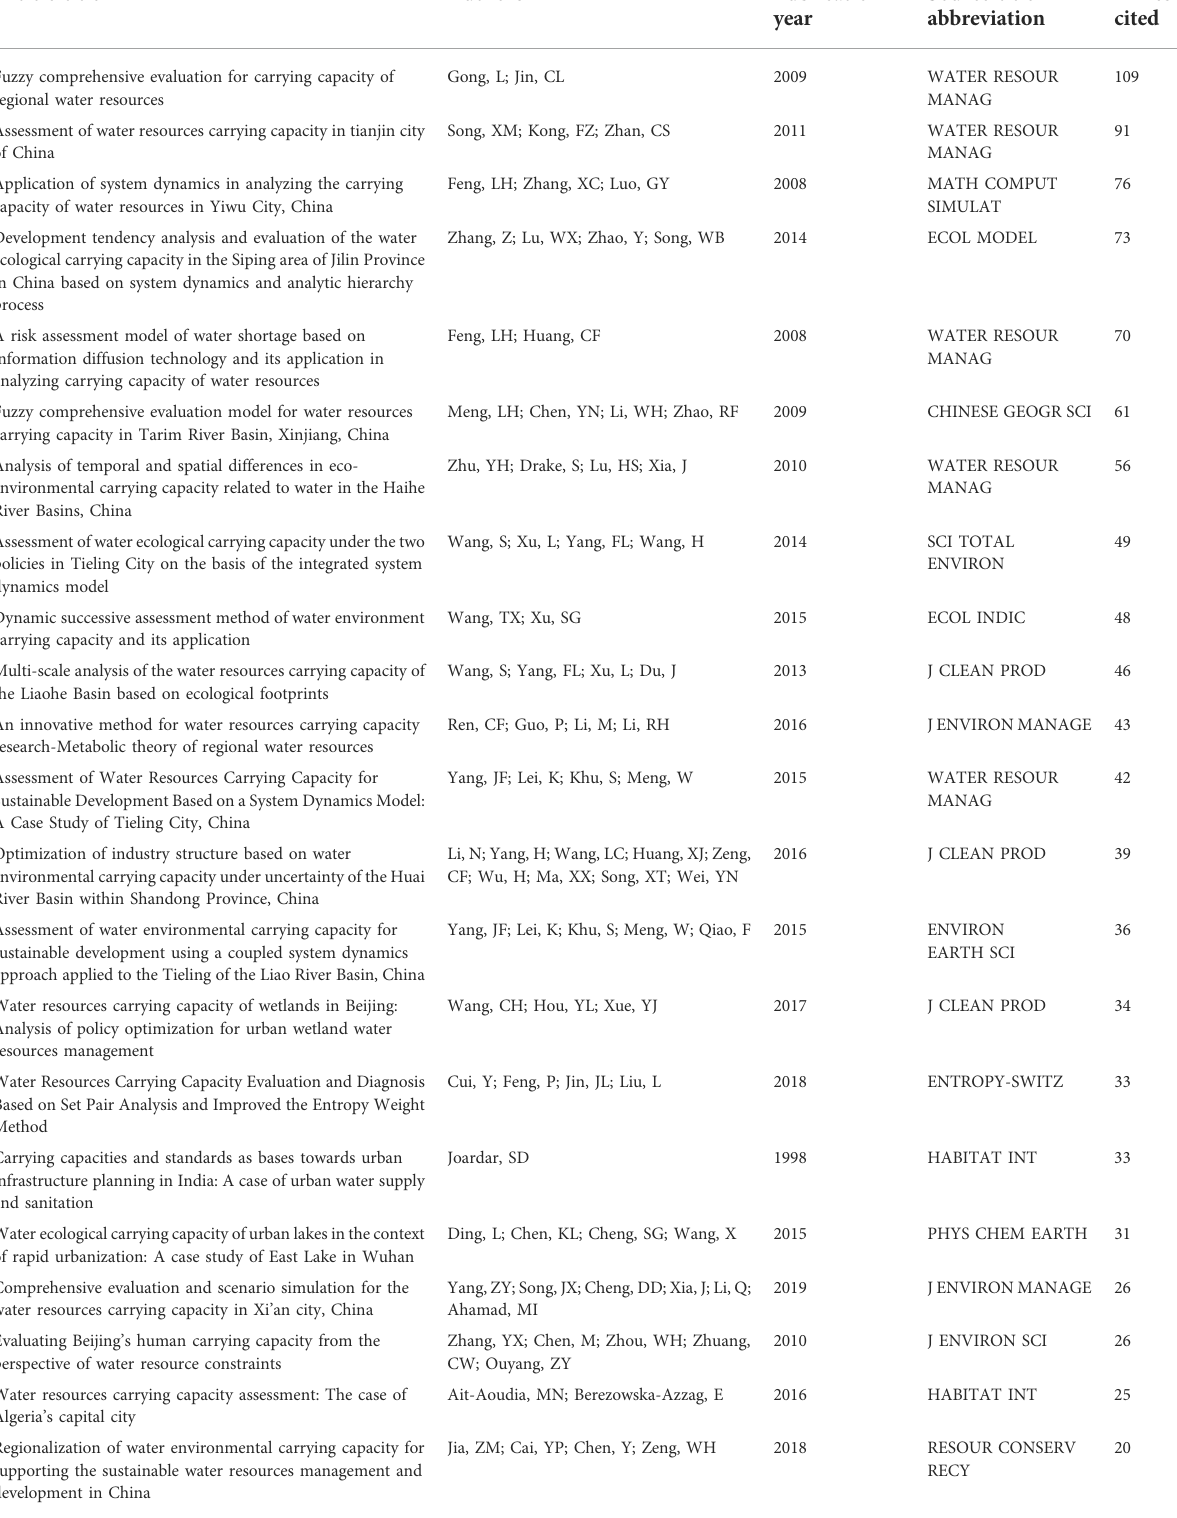
TABLE 1 TOP 30 highly cited papers (as of August 14,